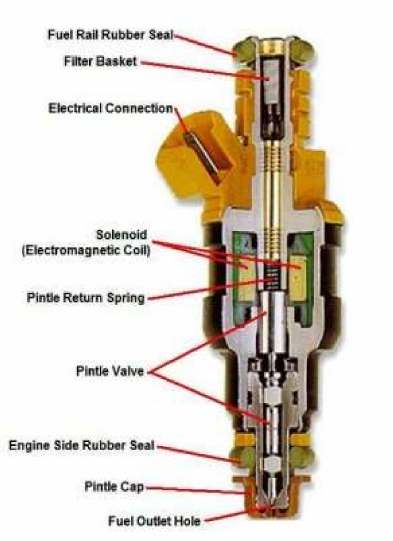
Figure 1. Schematic diagram of an electronically controlled